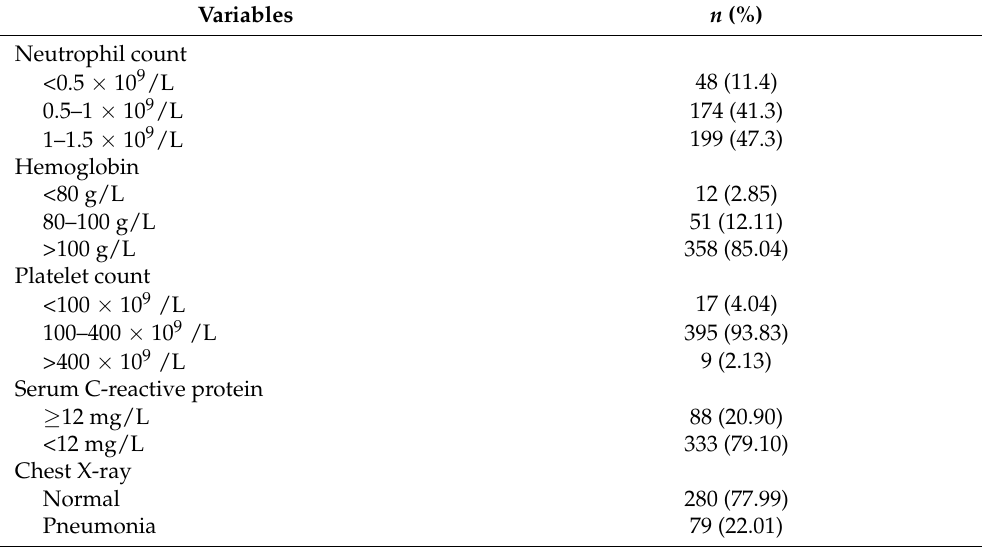
Table 3. Investigation results of children with febrile neutropenia ( n = 421).